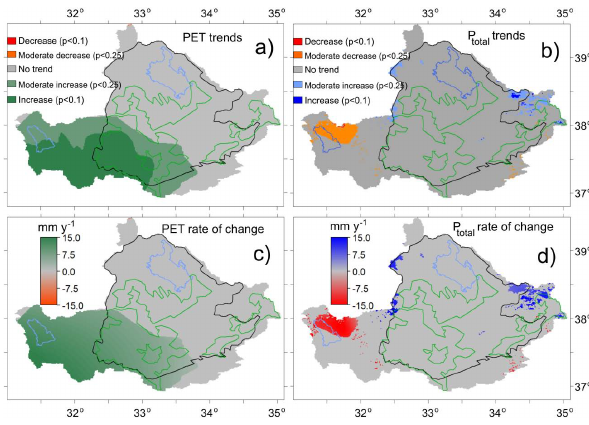
Fig. 13. (a) The cross relation between ET vs. PET trends, (b) cross relation between ET vs. PET trends (Note that “N.S.” represent “Not significant trend” in the legends of Fig. 13a and b), (c) histograms of ET, PET and P trends for the energy-limited part (outside Konya- plain polygon), (d) histograms of ET, PET and P trends for the water-limited part (inside Konya-plain polygon). Note that the his- tograms of all the three variables represents the represents the areas with significant ET trend ( p < 0 . 25) both in the energy- and water- limited